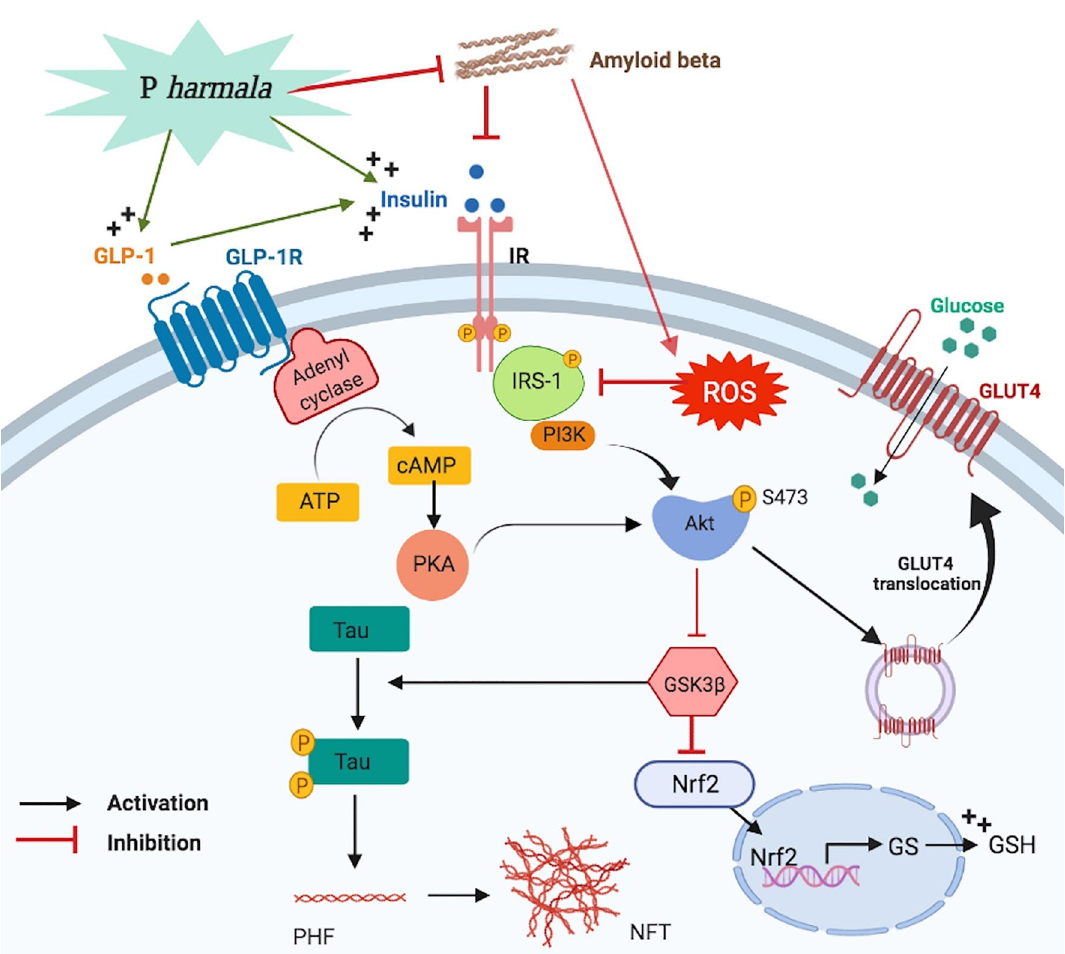
monophosphate, GLP‑1/GLP‑1R glucagon-like peptide-1/receptor, GLUT4 glucose transporter type 4, GS glutathione synthetase, GSH glutathione, IR insulin receptor, IRS‑1 insulin receptor substrate-1, Nrf2 nuclear factor erythroid 2-related factor 2, P harmala Peganum harmala , PI3K phosphoinositide 3-kinase, PKA protein kinase A, ROS reactive oxygen species. “Created with BioRender.com